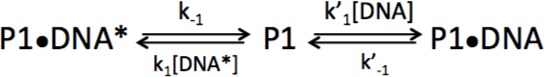
Kinetic model for dissociation of PARP1 from labeled dDNA in the presence of competing unlabeled DNA.